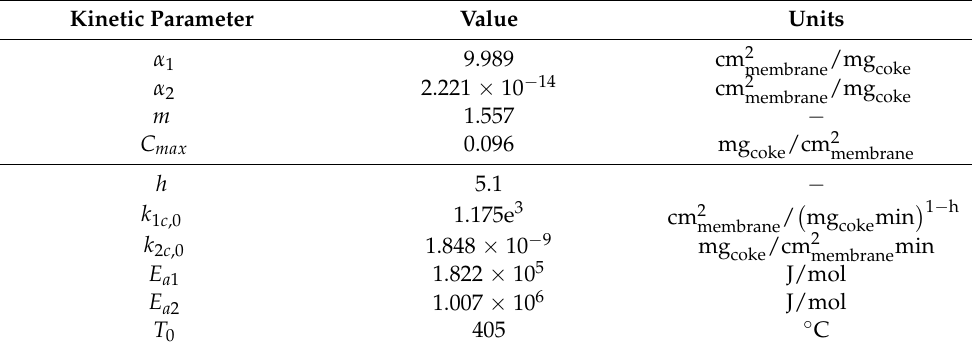
Table A4. List of parameters for the Pd-based membrane deactivation